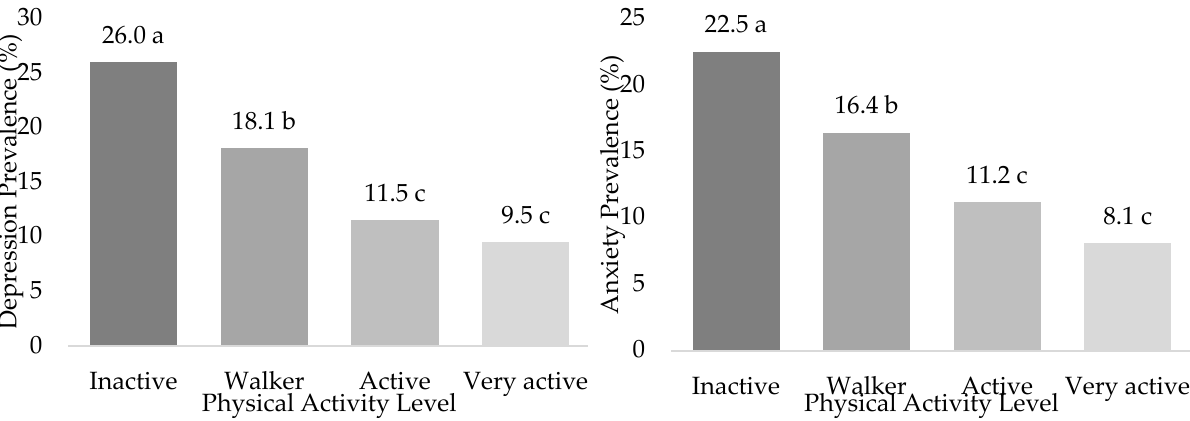
Figure 3. Depression and Anxiety status according to the Physical Activity Level in Spanish people with Hypertension (ENSE2017). abc (Different letters mean significant differences between Physical Activity group ratios. p < 0.05 from z-test).